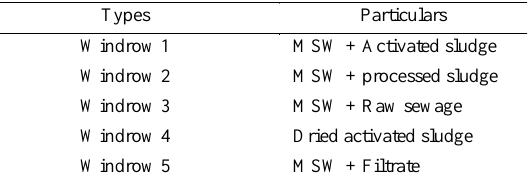
Table 1: Types of windrows based on their content